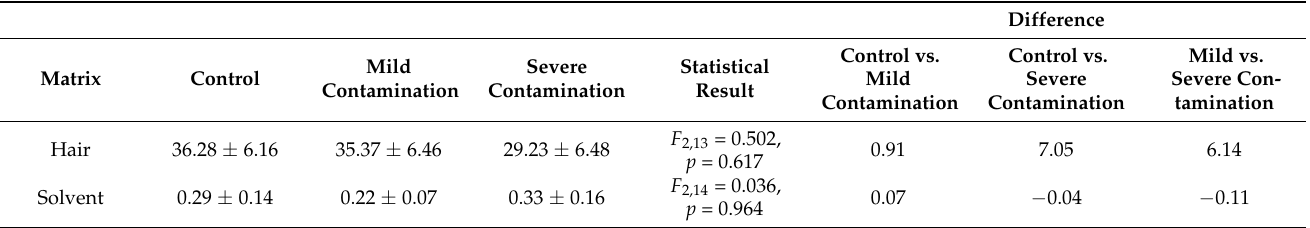
Table 2. Concentrations (pg/mg) of DHEA in the hair and wash solvent of the control (clean), mild, and severely contaminated (mixture of feces and urine) grower swine hair ( n = 16/treatment) following three 3 min methanol washes. Data are expressed as the mean ± SEM ( n = 8 per treatment). No statistical differences were